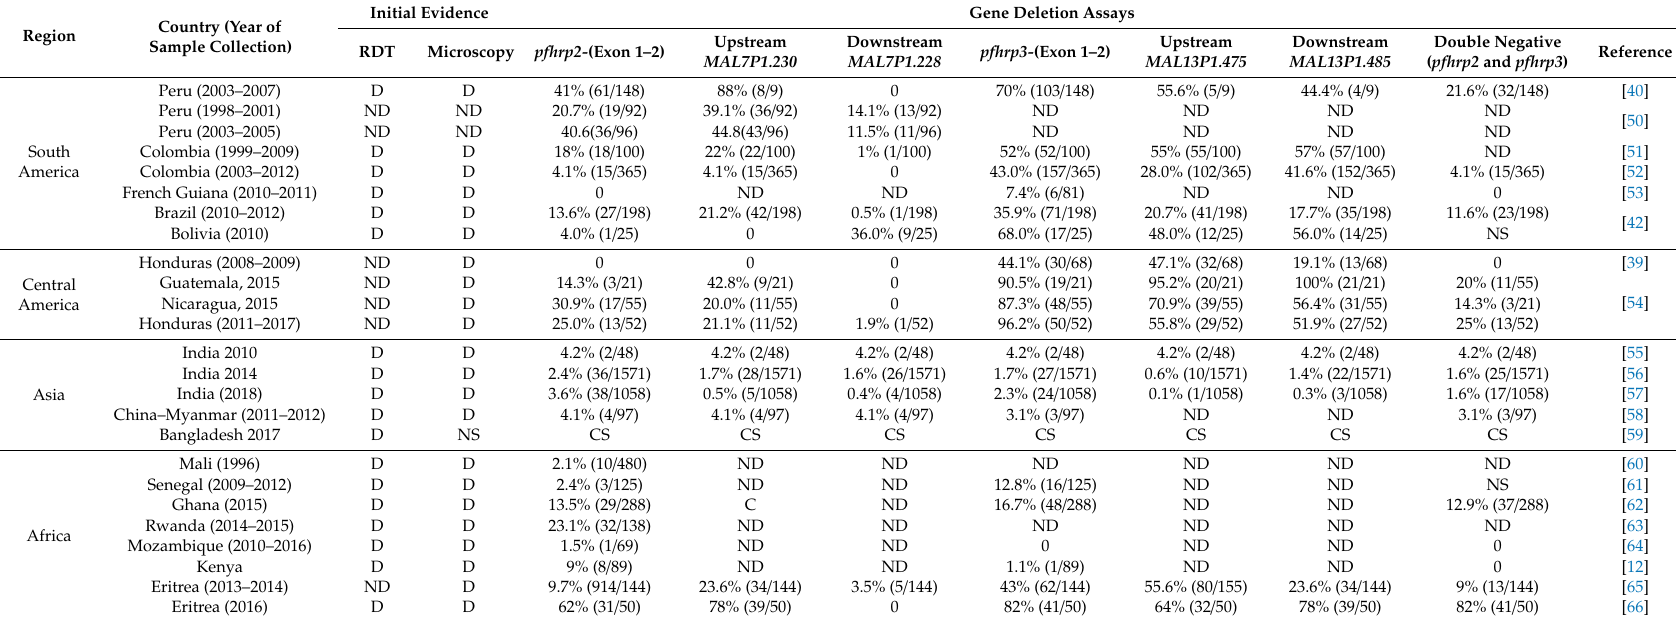
Table 1. Summary of studies reporting pfhrp2 / hrp3